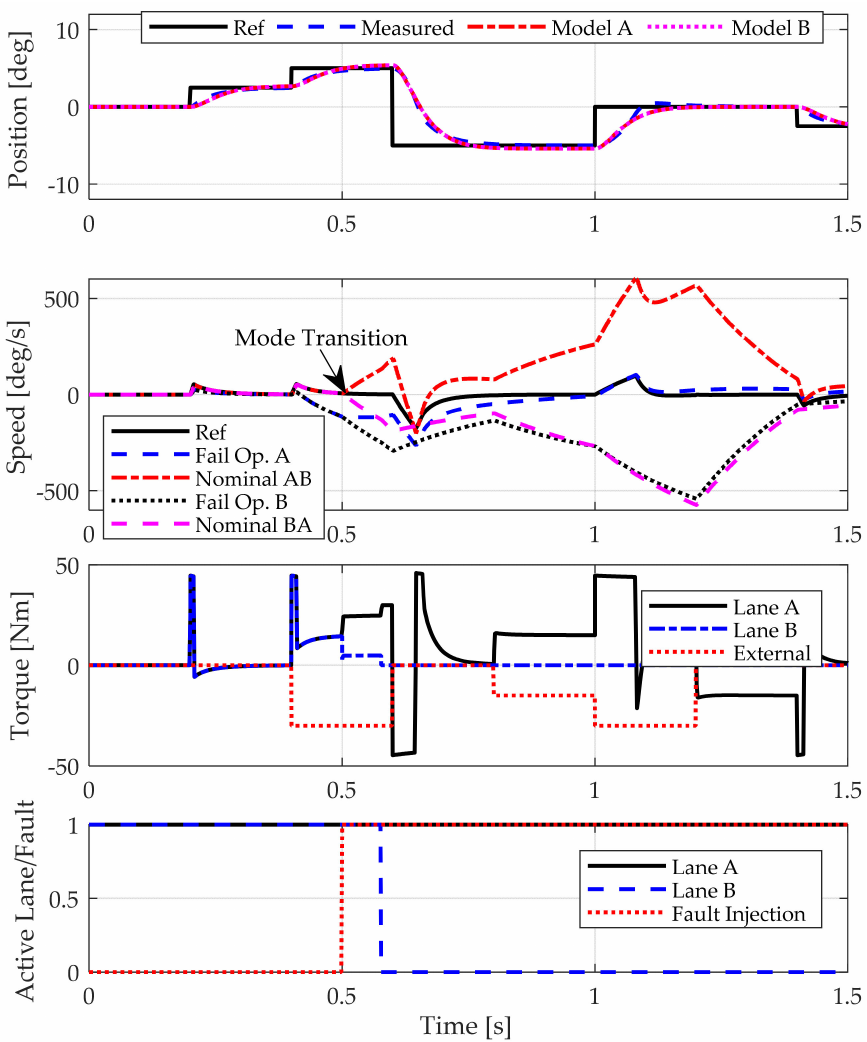
Figure 22. Example of a fail-operational after a local lane fault, fault ID = 16 in Table